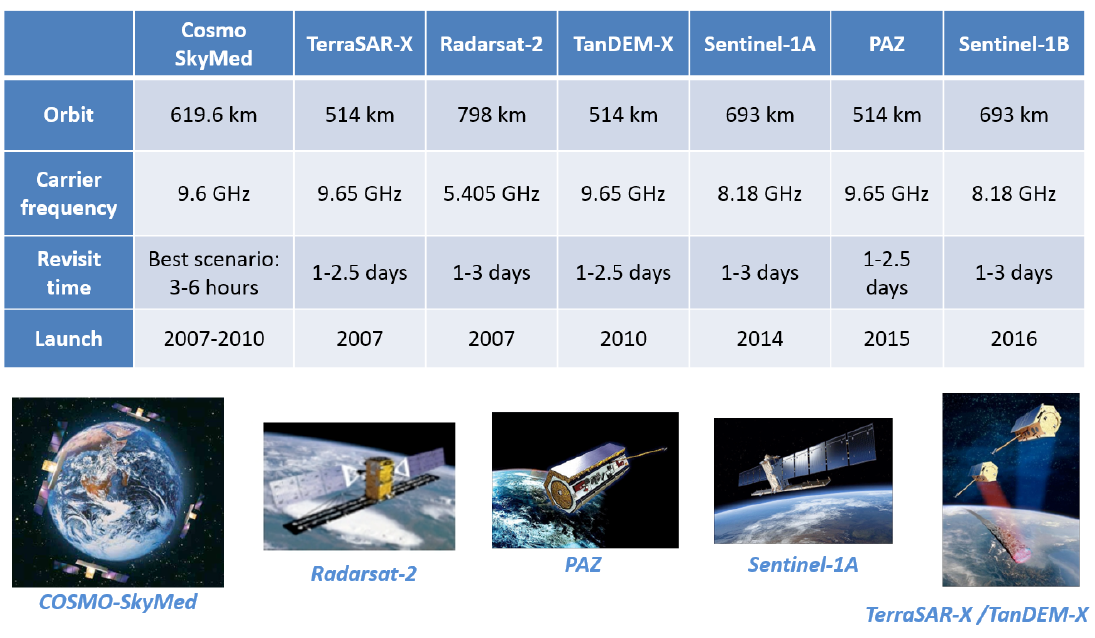
Figure 1. Operating SAR EO satellites’ main characteristics